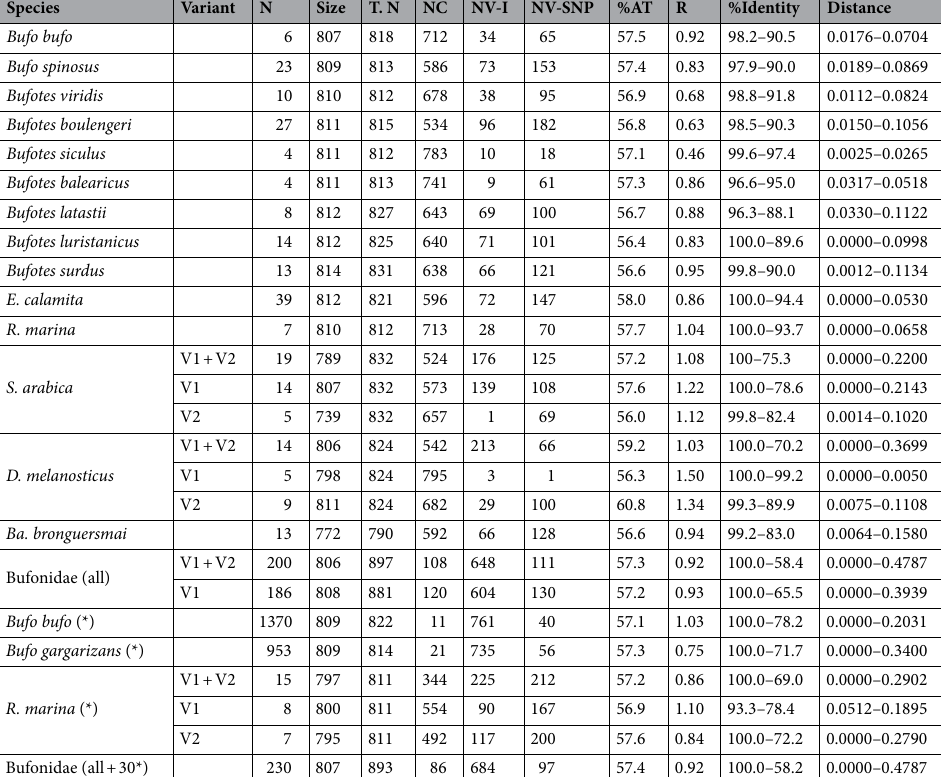
Table 2. Subfamilies of repetitive BamHI-800 and number of sequences found for each one. For each group of sequences with N: number of sequences; Size: average size of the sequences; T.N: total number of sites; NC: number of conserved positions; NV-I: number of variable informative sites; NV-SNP: number of single nucleotide polymorphisms; R: transitional pairs/transversional pairs. (*) Sequences from genome